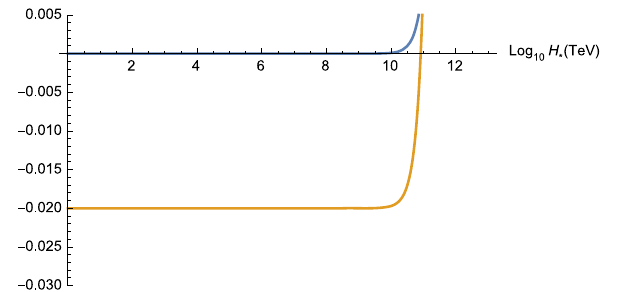
Fig. 8 A plot of (cid:14) ∗ and η ∗ versus the Hubble parameter H ∗ at the horizon exit. The blue line refers to (cid:14) ∗ and the orange one refers to η ∗ . Note that (cid:14) ∗ is much smaller than η ∗ for H ∗ (cid:2) 10 10 TeV, which fits